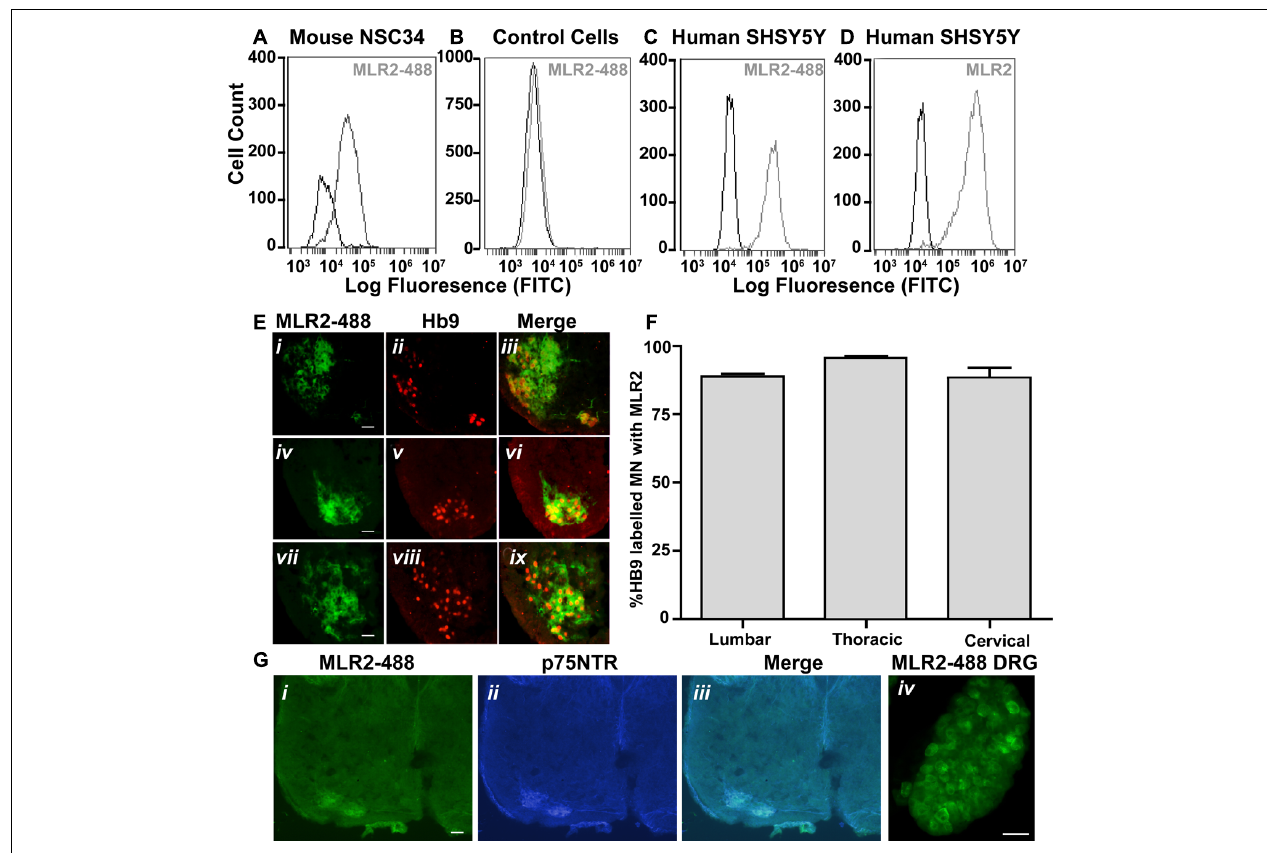
FIGURE 5 | MLR2 is specific for p75NTR and is transported to the majority of spinal motor neurons after intraperitoneal delivery into neonatal mice (A–D) Flow cytometry histograms demonstrating specificity of MLR2-488. Mouse motor neuron-like cells (A) , control fibroblasts (B) , human SHSY5Y neuroblastoma cells (C) were incubated with and without 20 μ g of fluorescently labeled anti-p75NTR (MLR2-488) and fluorescence measured by flow cytometry. X-axis is FITC fluorescence intensity;Y-axis is number of cells displaying FITC fluorescence. Flow cytometry histogram from human SHSY5Y (D) incubated with 20 mg unlabeled MLR2 and then anti-mouse 488 (1/100) is included as control for MLR2. (E) 488-Fluoresecence observed in lumbar (i), thoracic (iv), and